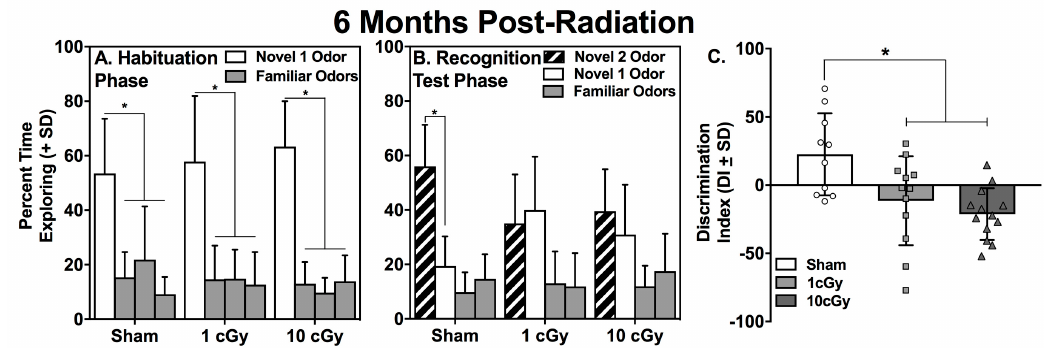
Figure 2. Mean percentage of exploration of novel and familiar odors for sham ( n = 10), 1 cGy ( n = 13), and 10cGy ( n = 13) 16 O ion exposed rats on ( A ) Trial 1 of Habituation and (B) Trial 1 of the Recognition Test at six months following exposure. All rats displayed significantly greater percentage of exploration of the novel 1 odor on Habituation compared to the familiar odors (* p ≤ 0.05). Only sham control rats displayed significantly greater exploration of the novel 2 odor during the Recognition Test (* p ≤ 0.05). Each group of bars in A and B represents mean percentage of exploration of the four odor-impregnated wooden beads during either Habituation or the Recognition Test. Solid white bars: novel odor 1. Solid gray bars: familiar odors. Hatched bars: novel odor 2. ( C ) The 1 and 10 cGy-exposed rats displayed discrimination indices significantly less than the sham control rats (* p ≤ 0.05); bars represent group averages and symbols represent individual animals. Table 2. Novel 1 odor (N1) exploration during Habituation at six months